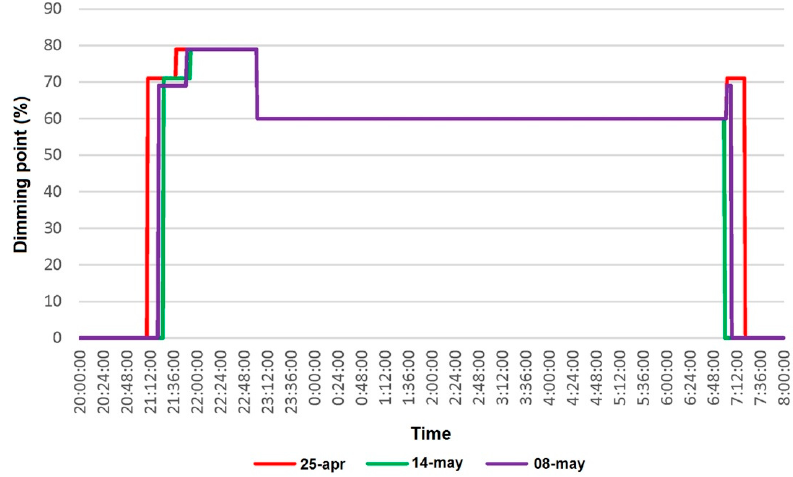
Figure 21. Data collected by the SCADA system (lamp #1).